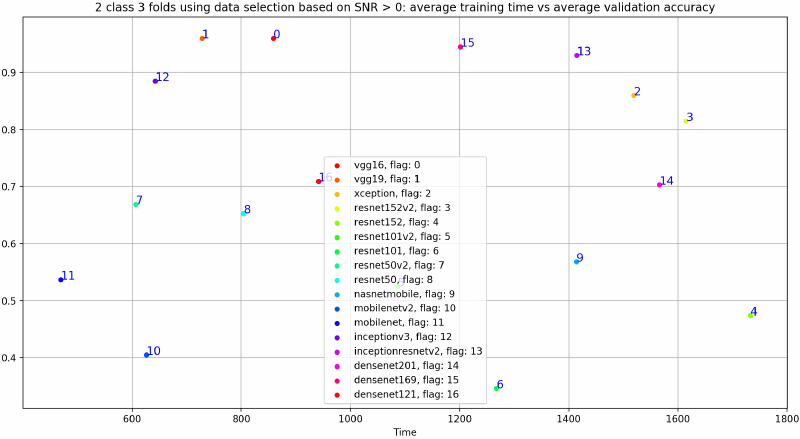
Figure 24. Training time vs. validation accuracy using data selection based on SNR ≥